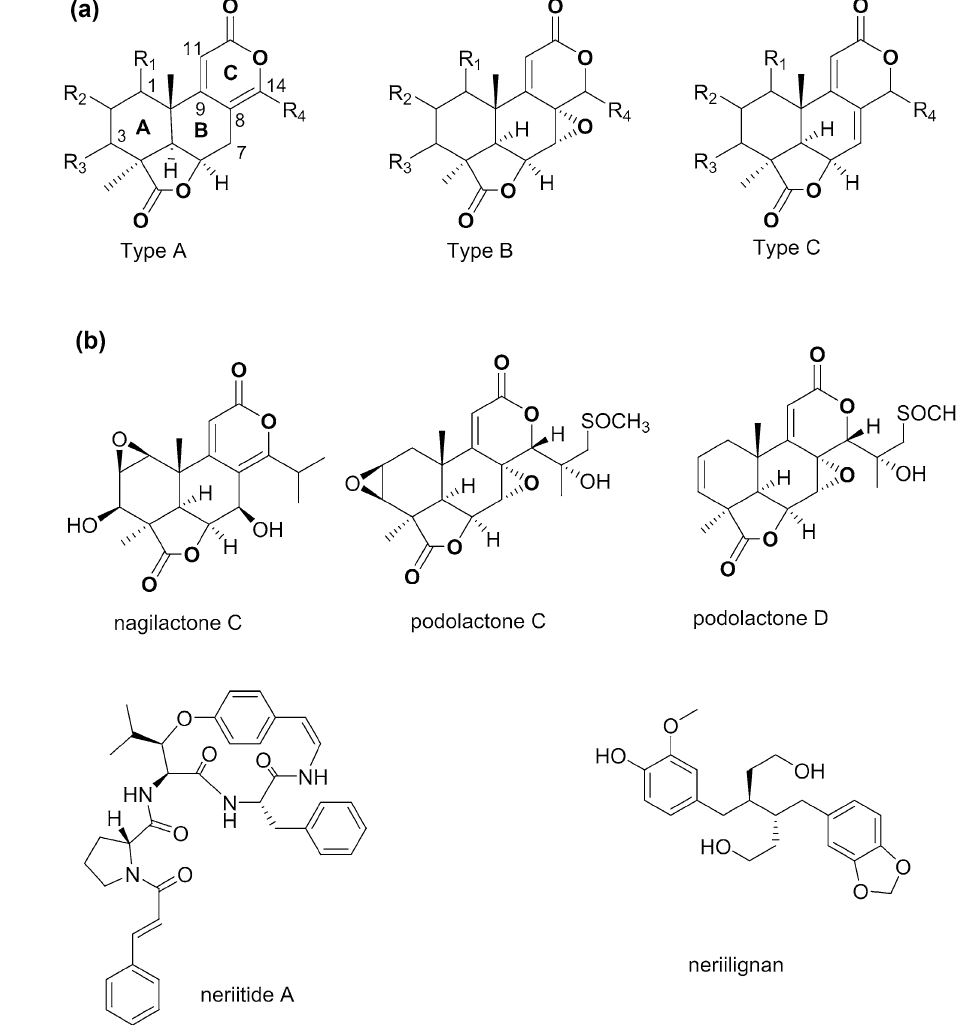
Fig. 1 a Podolactone classifica- tion and b examples of previ- ously isolated compounds from P.